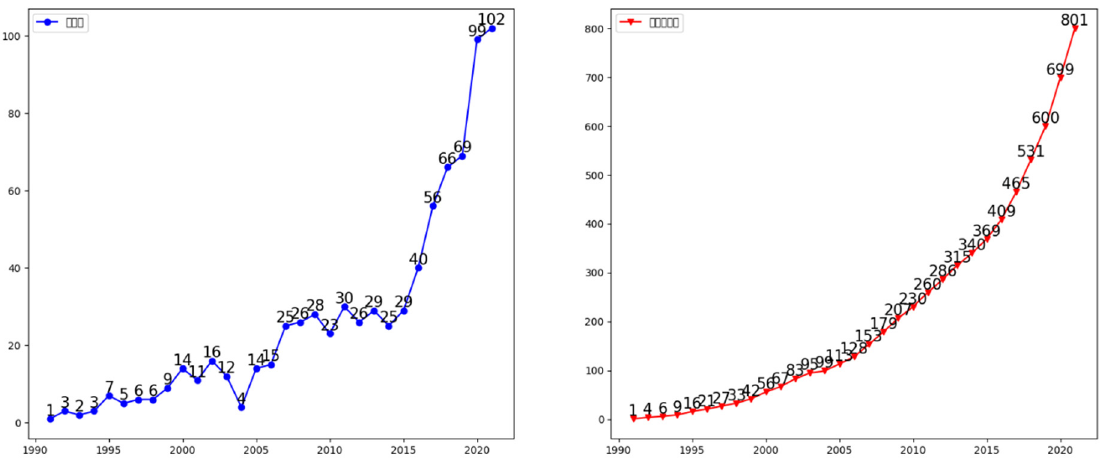
Figure 2. Distribution and cumulative volume of foot reflexology papers published over the years.